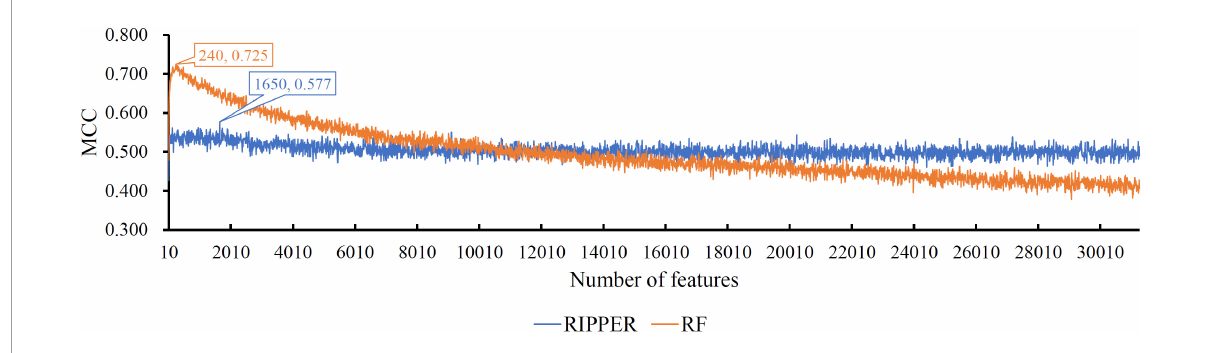
FIGURE2 The IFS curves of RIPPER and RF. RIPPER can reach the highest MCC of 0.577, whereas RF can reach the highest MCC of